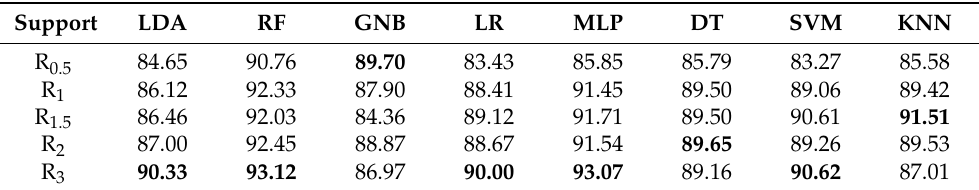
Table 3. The overall accuracy of the methods in Dublin City Area 1. The highest-obtained accuracies are shown as